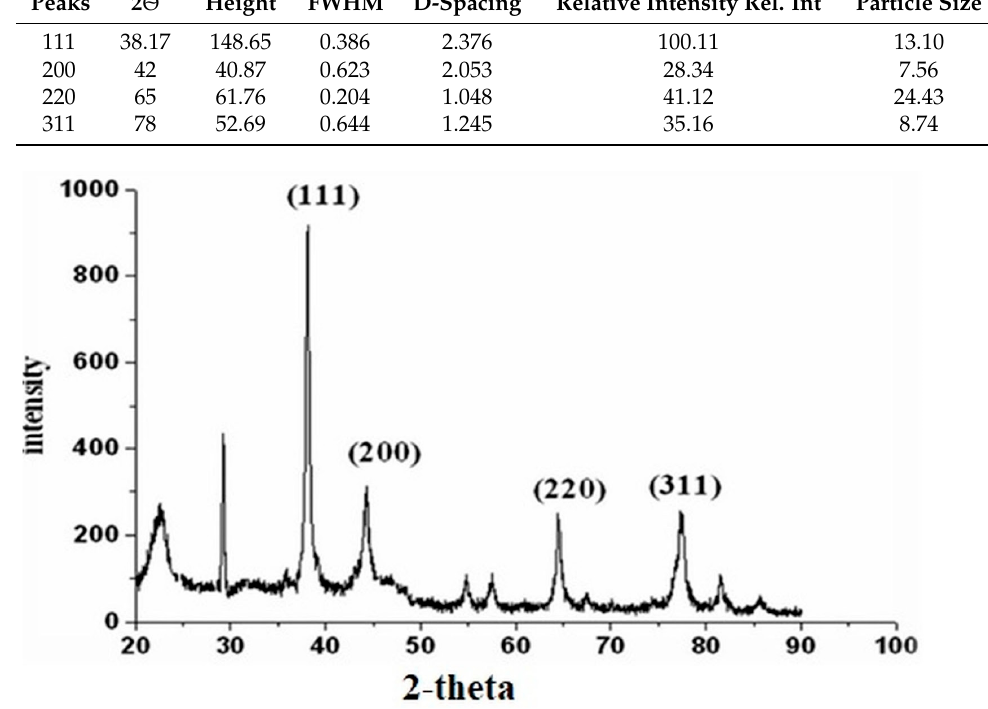
Table 1. Measurement the size of biosynthesized silver nanoparticles with Elaeagnus umbellata (fruit extract) by using Debye–Scherrer equation. Figure 2. UV - Vis absorption spectra of silver nanoparticles at different time intervals synthesized from Elaeagnus umbellata fruit extract. 3.2.2. X-ray Diffraction (XRD) Peaks 2 Ѳ Height FWHM D-Spacing Relative Intensity Rel. Int Particle Size 111 38.17 148.65 0.386 2.376 100.11 13.10 200 42 40.87 0.623 2.053 28.34 7.56 220 65 61.76 0.204 1.048 41.12 24.43 311 78 52.69 0.644 1.245 35.16 8.74 The intensity of Bragg’s reflection at 38.17° was a good signal that fruit-mediated silver nanoparticles were cubic. The lattice constants ‘a’ were calculated as 4.106 nm, which agreed well. The size of the AgNPs was calculated by using the FWHM value in